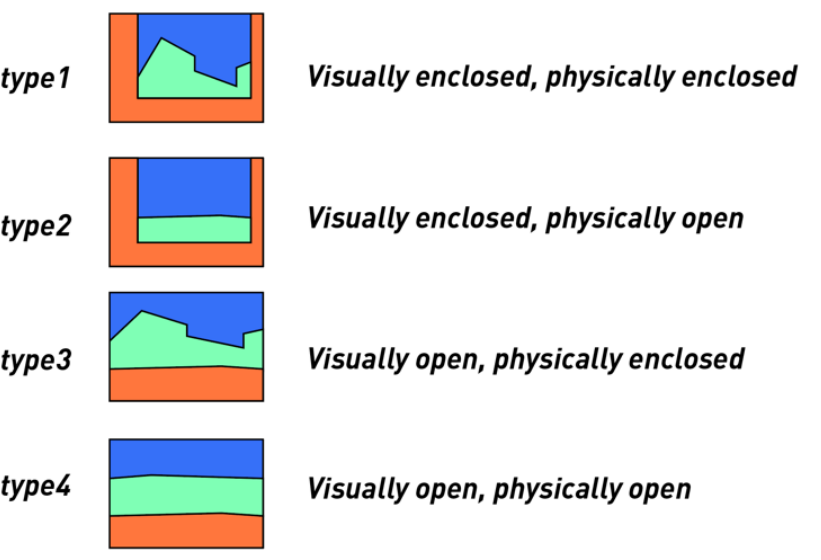
Figure 9. Enclosure type of the visual based on the entropy images.